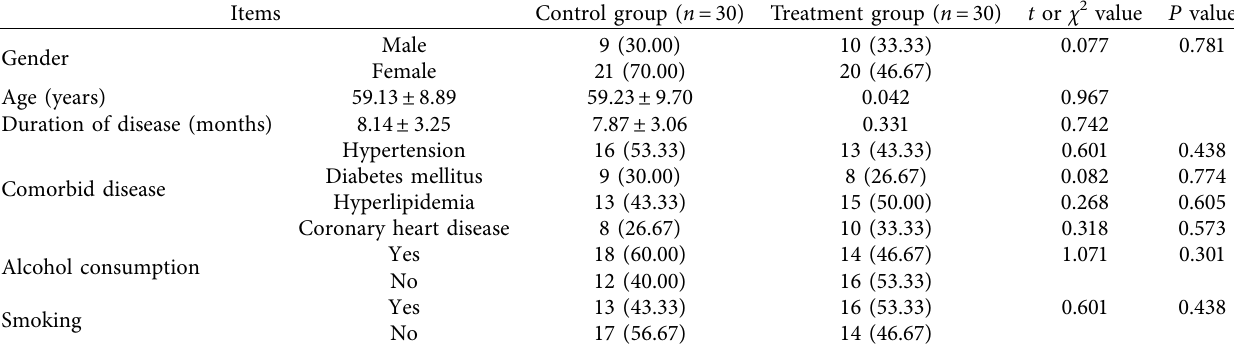
Table 1: Comparison of general information between the two groups at admission [( x ± s ); n , %].